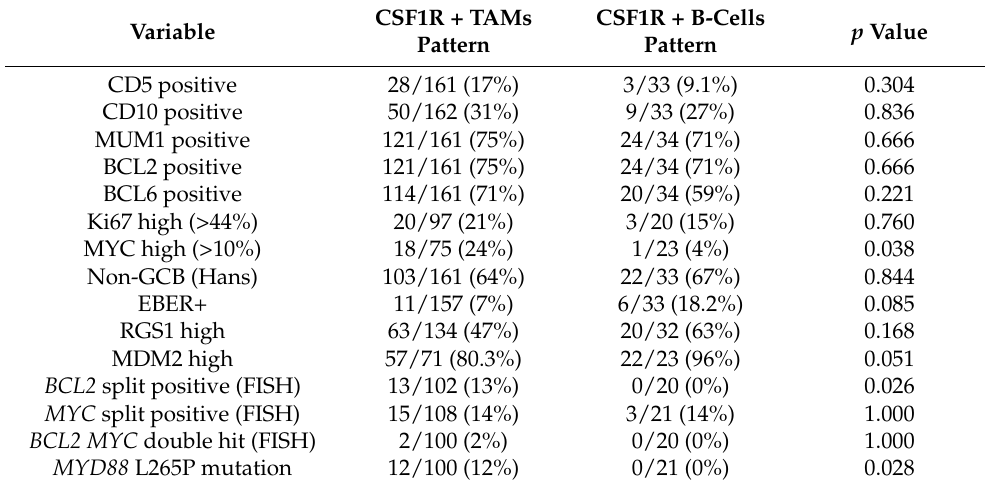
Table 4. Correlation between the histological patterns of CSF1R and the pathological characteristics of the samples (Tokai